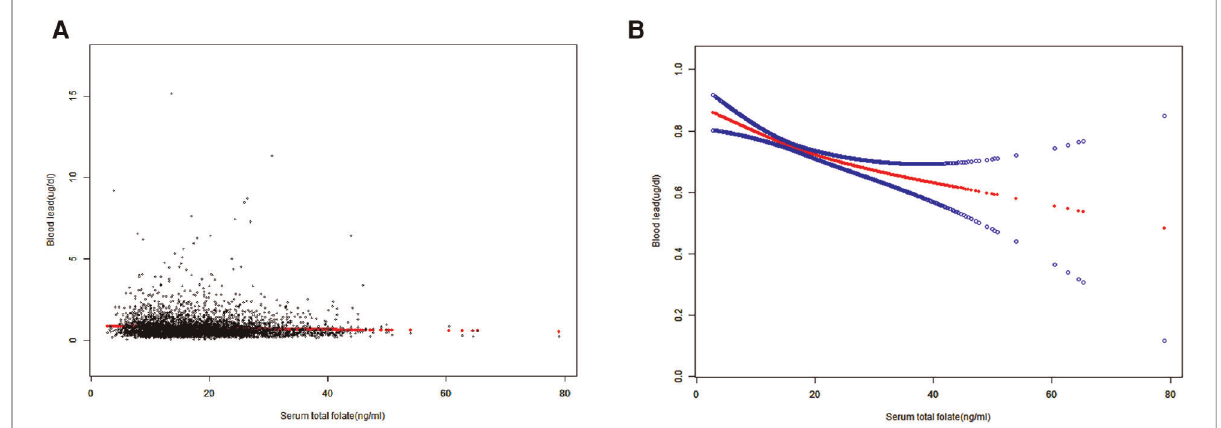
FIGURE 2 Smooth curve fi tting of serum folate concentrations and blood lead levels. ( A ) Each black point represents a sample. ( B ) The area between two blue dotted lined is expressed as a 95% CI. The solid red line represents the smooth curve fi t between the variables.Age, sex, race, ratio of family income to poverty, body mass index, aspartate aminotransferase, alanine aminotransferase, total cholesterol, blood urea nitrogen, serum creatinine, serum cotinine, folate supplements were